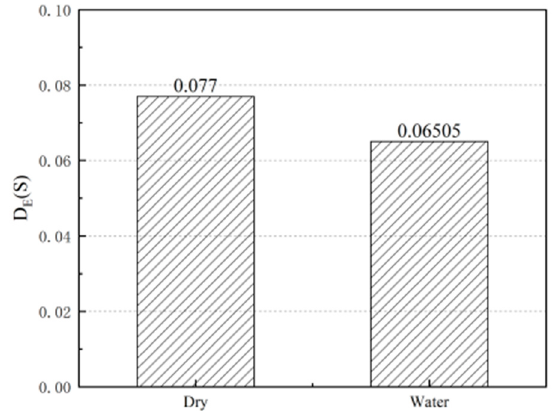
Figure 10. D I of CR mixture before and after immersion under medium temperature fatigue failure.